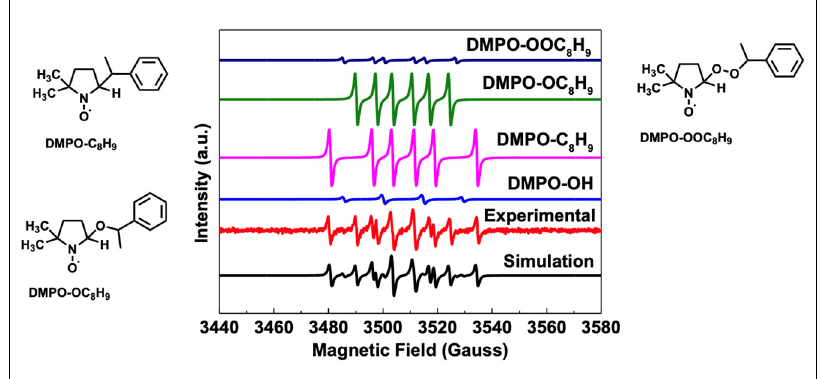
Figure 7. Computed and experimental EPR spectrum of DMPO spinning adducts and DMPO spinning adducts structures.